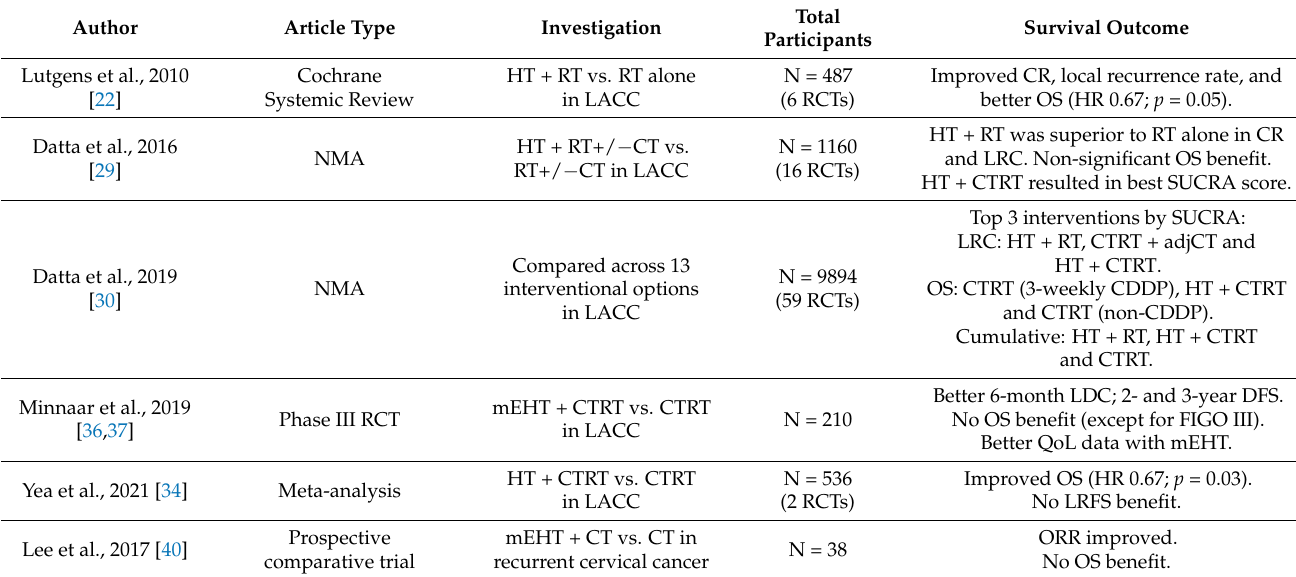
Table 1. HT in patients with cervical cancers. Summary of articles